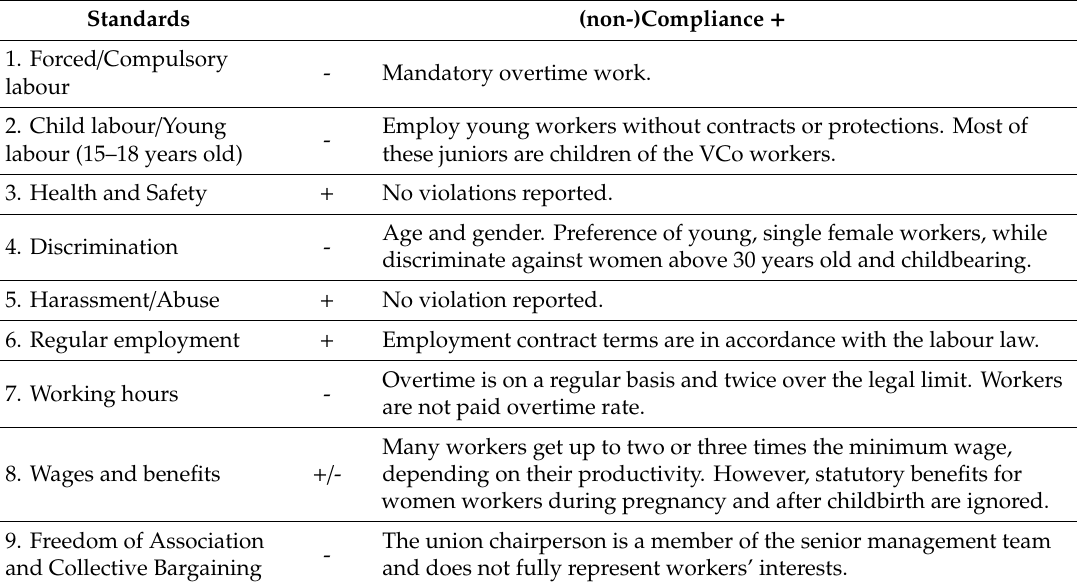
Table 3. Summary of CoC compliance at